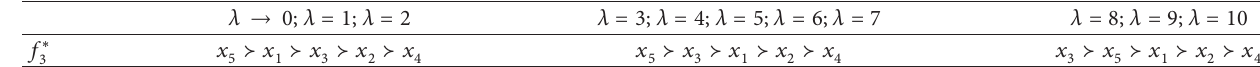
Table 7: Rankings of the alternatives with different 𝜆 by using 𝑓 ∗ 3